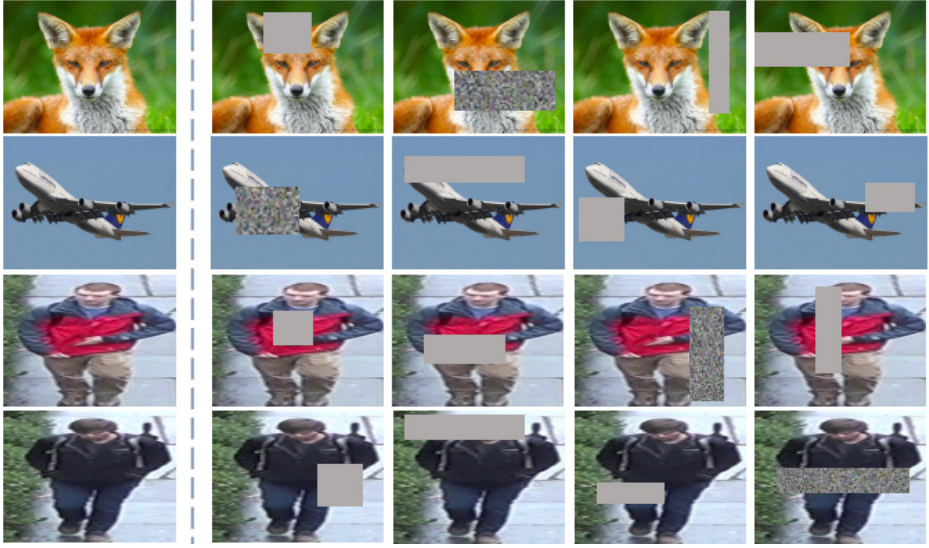
Figure 5. Random image erasure operation.